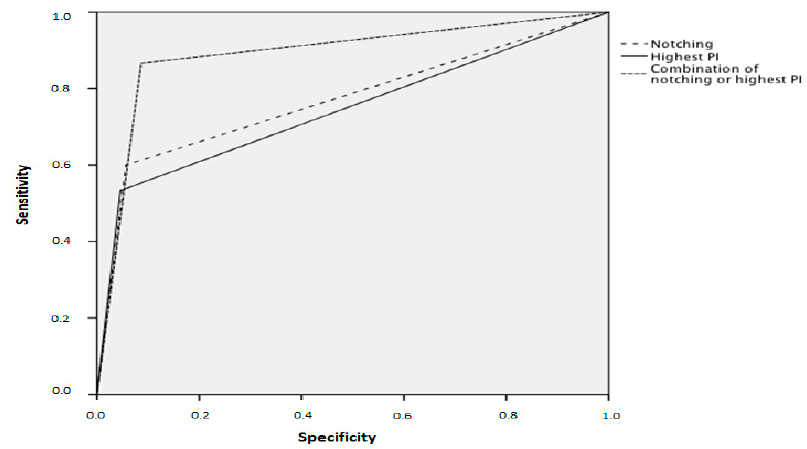
Figure 2. Screening receiver operating characteristics curves for prediction of early preeclampsia.